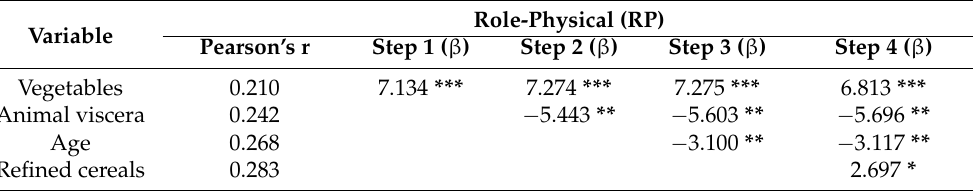
Table 4. Stepwise regression predicting the PF scores.